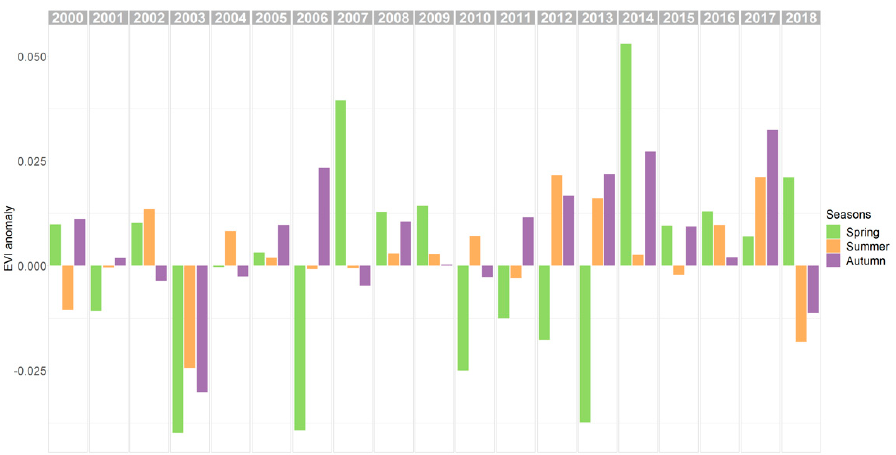
Figure 3. Seasonally averaged Enhanced Vegetation Index (EVI) anomalies for Germany for the years